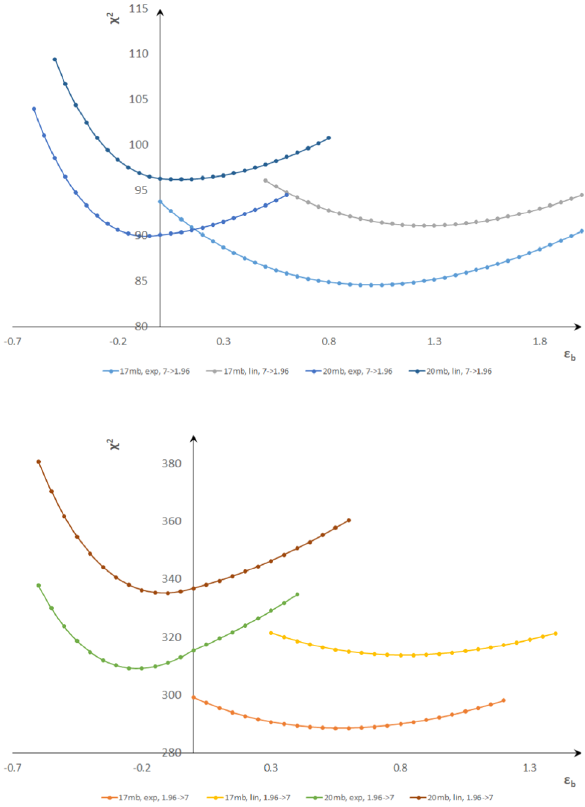
Fig. 9 Dependence of χ 2 on the coefficient of the correlated but point- to-point varying systematic errors, (cid:13) b , for the comparison of the H ( x ) √ s = 1 . 96 TeV with that scaling functions of elastic p ¯ p collisions at √ s = 7 . 0 TeV. Each of the four cases are shown of pp collisions at together corresponding to the direction of the projection. Upper panel indicates the results of the 1.96 → 7.0 TeV projection. Lower panel indicates the results of the 7.0 → 1.96 TeV projection. Both cases indicate four χ 2 ((cid:13) b ) curves corresponding to the choice of linear-linear orlinear-exponentialinterpolationsin ( x , H ( x )) ,aswellastothechoice √ s = 1 . 96 TeV (20.2 ± 1.4 mb vs of the elastic p ¯ p cross section at 17.6 ± 1.1 mb). A parabolic structure is seen in each case with a clear minimum, and the fit quality corresponding to these minima in (cid:13) b is summarized in Table 2 √ s = 1 . 96 1.1 mb for the elastic p ¯ p cross section at